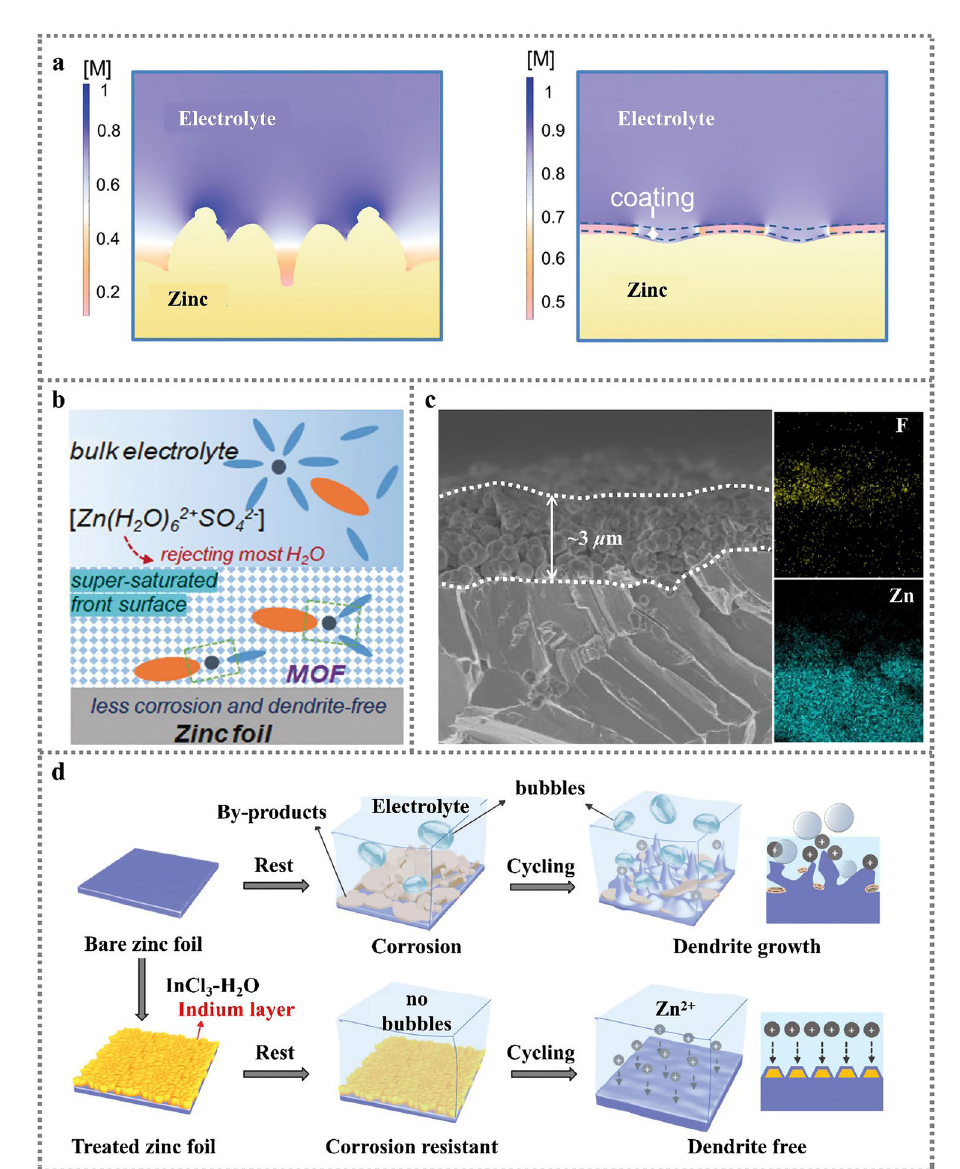
Fig. 7 a The electrode surface before and after adding PDMS/TiO 2- x coating about distribution of Zn-ion concentration [75]; Copyright 2022, Wiley–VCH. b Function mechanism of the MOF coating layer to reject H 2 O and construct a super-saturated front surface [76]; Copyright 2020, Wiley–VCH. c Cross-sectional SEM image of the Zn soaked in the electrolyte and the corresponding EDX maps. Scale bar, 2 μm [77]; Copy- right 2021, Springer Nature. d Schematics of the behavior of bare Zn and Zn|In anodes in an aqueous ZnSO 4 electrolyte [78]. Copyright